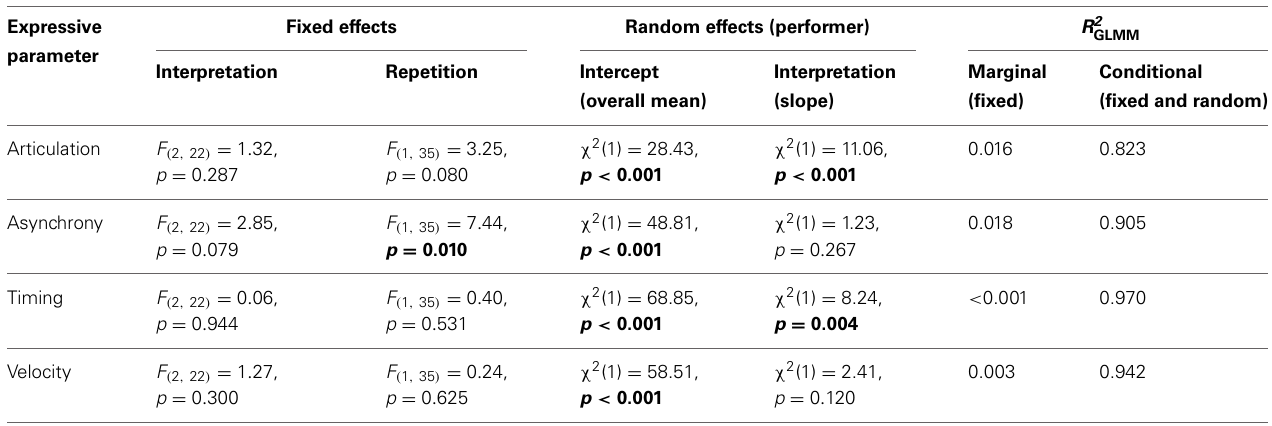
Table 3 | Linear mixed models comparing across interpretations of the Partita